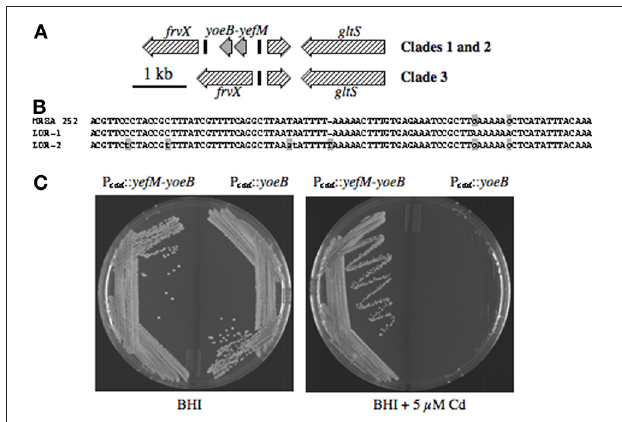
FIGURE 4 | (A) Illustration of yefM-yoeB and flanking DNA in CC30. yefM-yoeB are flanked by repeats LDR-1 and LDR-2 (black bars) in PT80/81 and ST30 spa19 CA-MRSA, whereas HA-MRSA and contemporary MSSA have only one LDR and lack yefM-yoeB . (B) Nucleotide sequence of LDR-1 and LDR-2 from strain M1015, and the single LDR of MRSA 252. The lower-case gray shaded nucleotides differentiate LDR-1 and LDR-2. The single LDR of MRSA 252 is a hybrid of LDR-1 and LDR-2, which is suggestive of a recombination event. (C) Growth of S. aureus RN4220